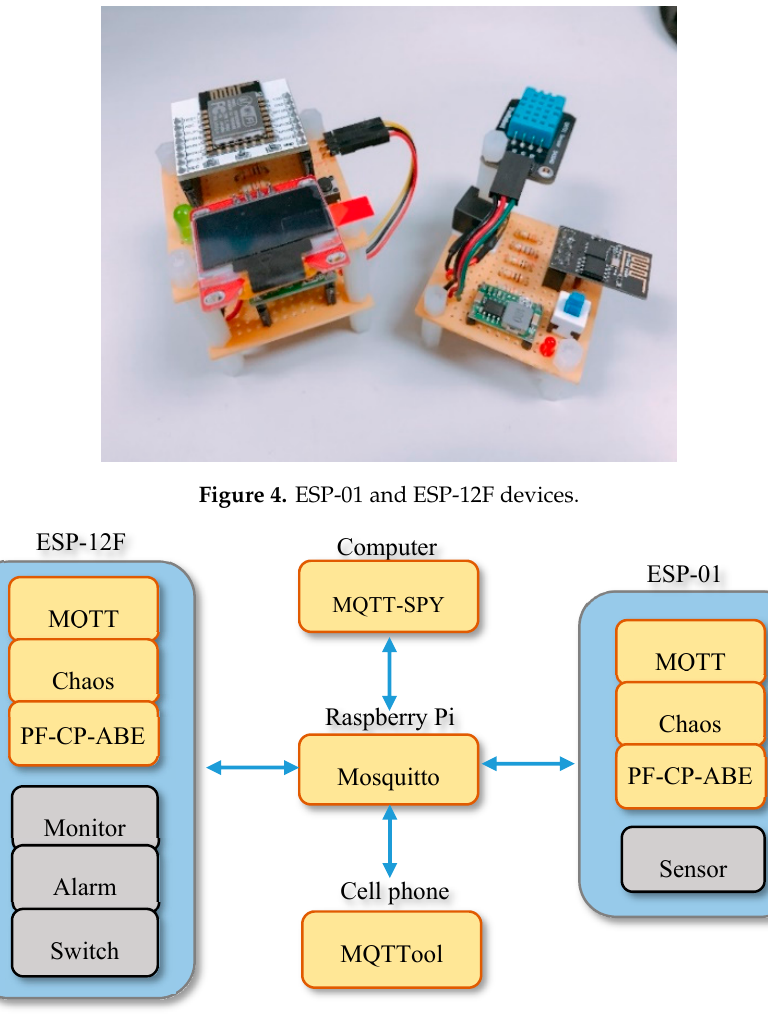
Figure 6. Non-synchronization Chaos Synchronization Attribution-Based Encryption Scheme (CS- ABE) flow chart.